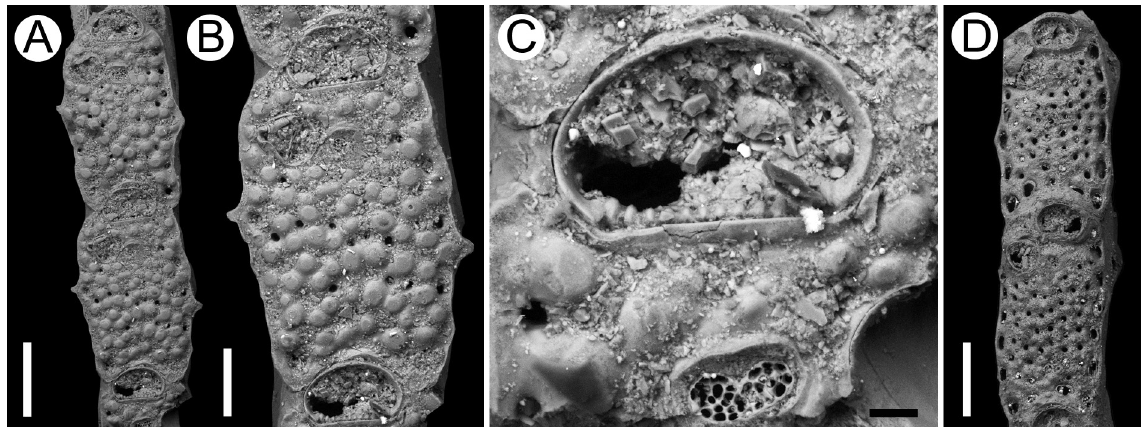
Fig. 5. Microporella ordo Brown, 1952. A –C . Holotype (NHMUK D36809), Wanganui, Castlecliffian Horizon CU3, Pleistocene, NZGS Loc. 4013 Castlecliff, New Zealand. A . Frontal view of the linear colony fragment. B . Close-up of an autozooid. C . Close-up of the orifice and ascopore. D . Paratype (NHMUK D36806), same provenance as holotype, view of the linear colony fragment. Scale bars: A, D = 200 µm; B = 100 µm; C = 20